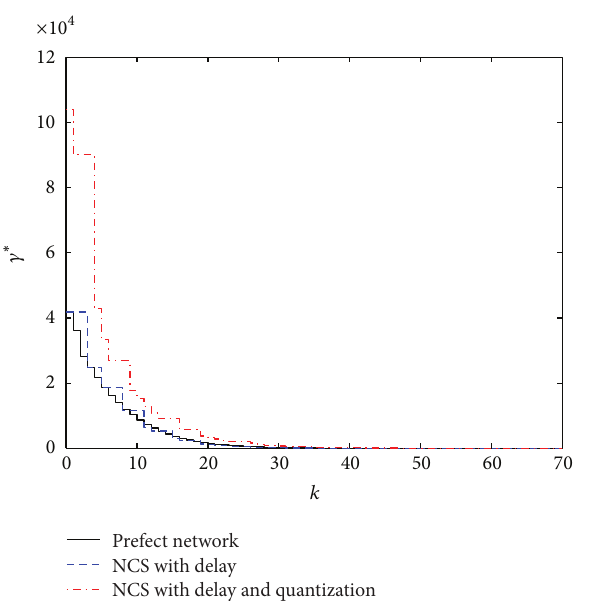
Figure 8: The evolution of 𝛾 ∗ (Example 1).